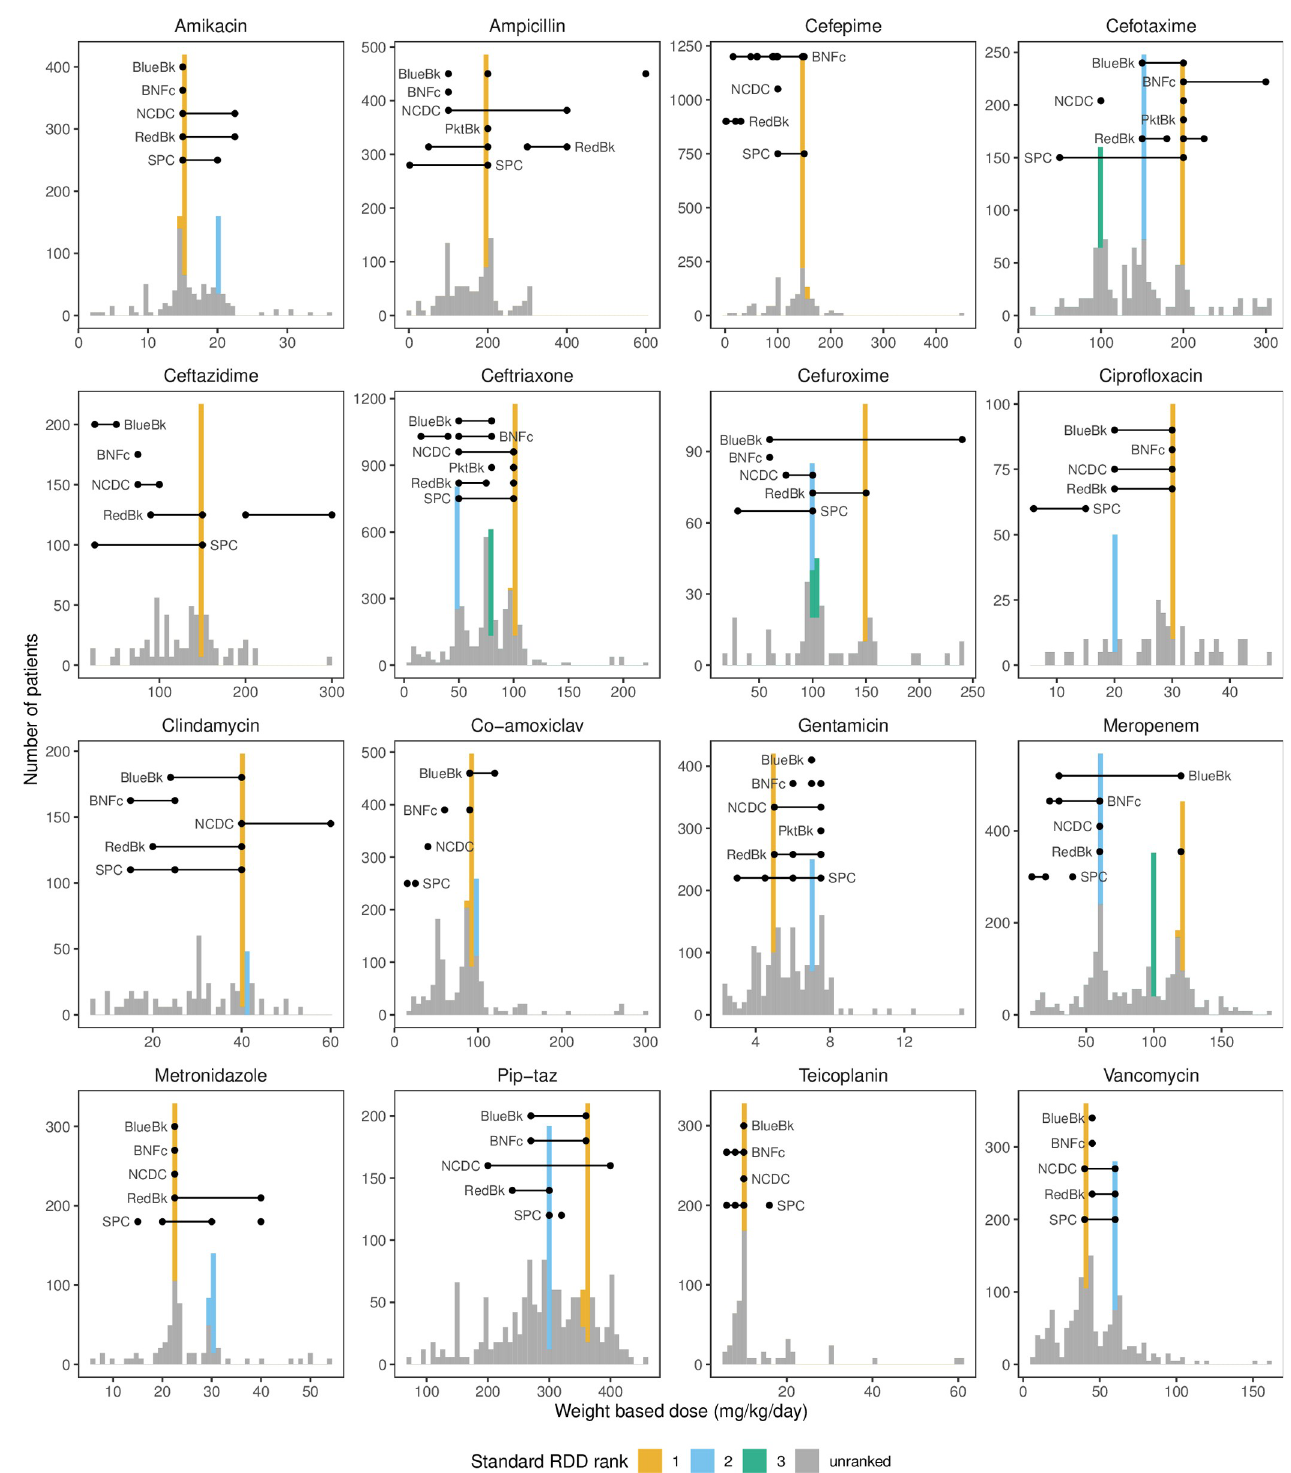
Fig 2. Antibiotics showed between one and three peaks (coloured bars) consistent with dosing by standard WBD. Overlaid are guideline recommendations for IV dosing in children, generally and for priority syndromes (severe infection, pneumonia, sepsis, acute otitis media, pharyngitis, urinary tract infection) from five different guidelines: Blue Book (BlueBk), British National Formulary for children (BNFc), Indian National Centre for Disease Control (NCDC), WHO pocket book (PktBk) and Red book (RedBk). Multiple entries for a single guideline indicate different frequencies of daily dosing, indications (e.g.